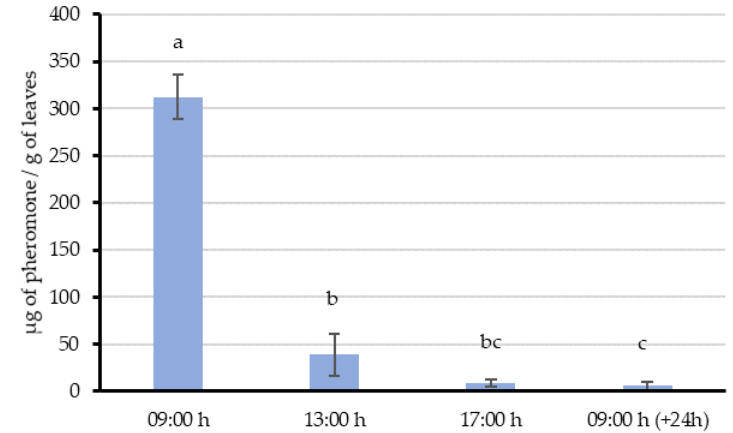
Figure 2. Mean ( ± SE) quantity of pheromone ( µ g pheromone / g leaves) adsorbed on leaf samples of Figure 2. Mean (± SE) quantity of pheromone (µg pheromone/g leaves) adsorbed on leaf samples of Experiment 1, after one aerosol emission. Bars labeled with di ff erent letters are significantly di ff erent, Experiment 1, after one aerosol emission. Bars labeled with different letters are significantly different, ANOVA followed by the Fisher LSD test (F = 48.996; df = 3, 15; p < ANOVA followed by the Fisher LSD test (F = 48.996; df = 3, 15; p < 0.001).